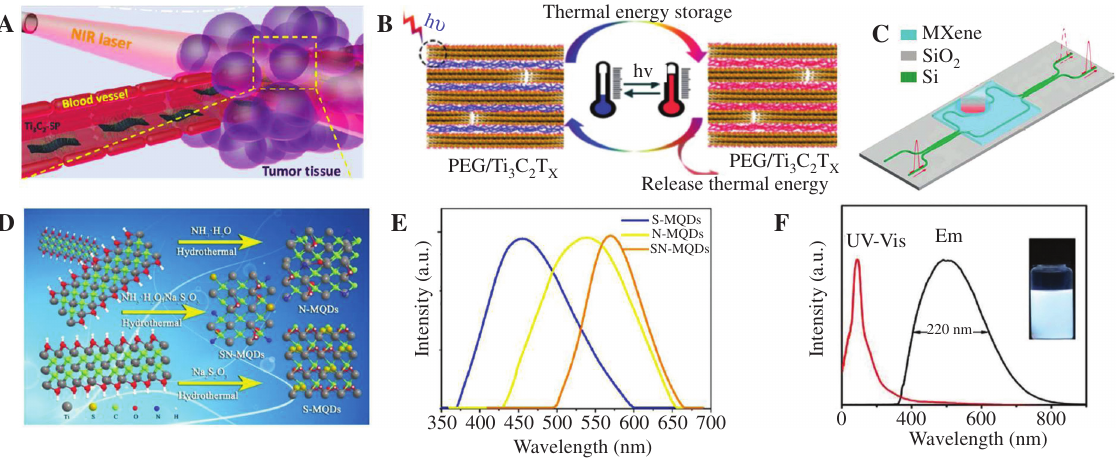
Figure 11: MXene applications for photothermal storage and QD LED. (A) Soybean phospholipid modified Ti and storage of PEG/MXene phase change materials. (C) Schematic of integrated photothermal optical sensor with Si and Ti Schematic of synthesis of S-MQDs, N-MQDs, and SN-MQDs. (E) Photoluminescence spectra of visible-light-emitting MQDs under 360 nm emission. (F) UV-vis absorption, fluorescence excitation, and emission spectra of Ti under UV illumination. (A) Reproduced with permission [147]. Copyright 2017, American Chemical Society. (B) Reproduced with permission [173]. Copyright 2019, the Royal Society of Chemistry. (C) Reproduced with permission [58]. Copyright 2019, Walter de Gruyter.